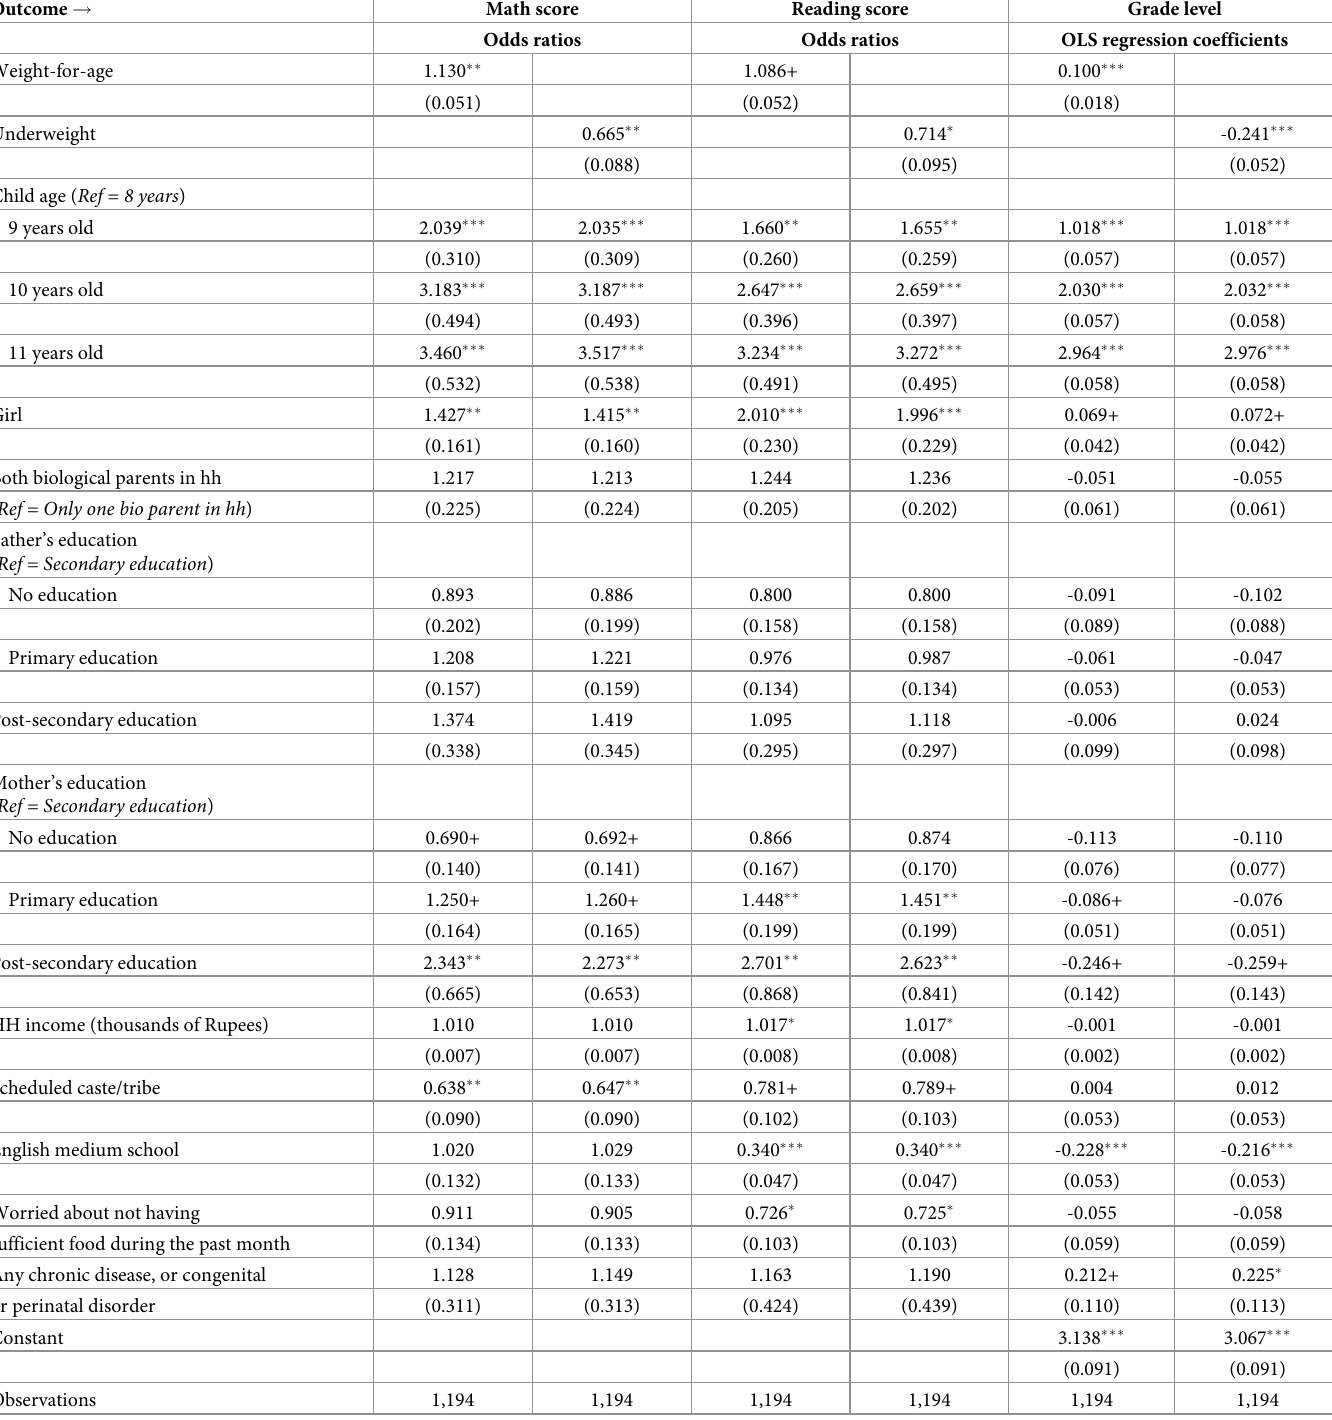
Table 4. Adjusted models for the association between cognitive achievement and educational attainment and weight-for-age z-scores and